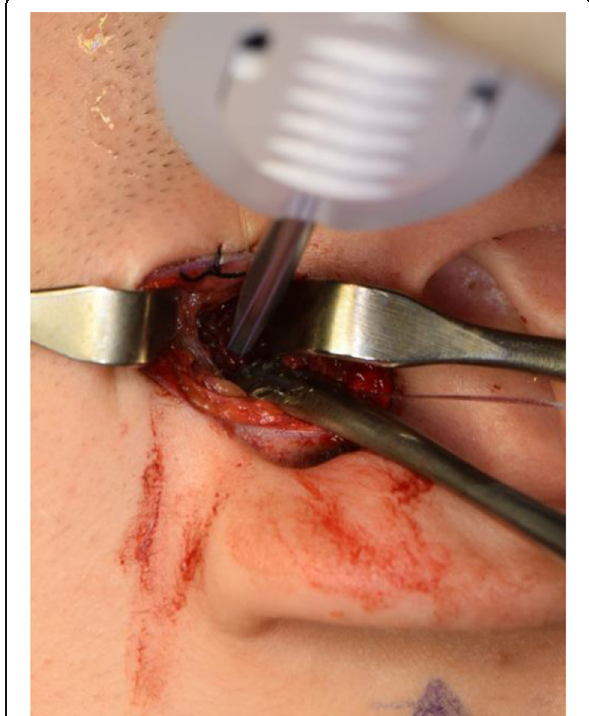
Fig. 7 MITEK mini anchor placement at most lateral, superior, and posterior aspect of mandibular